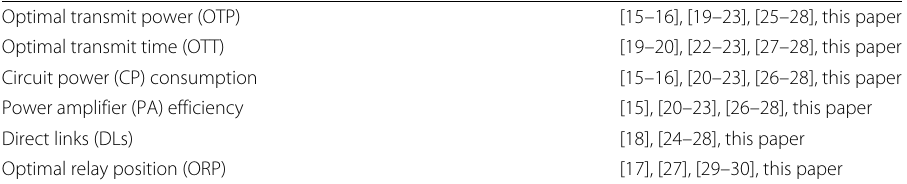
Table 1 Existing literature comparison with this paper Optimal transmit power (OTP) Optimal transmit time (OTT) Circuit power (CP) consumption Power amplifier (PA) efficiency Direct links (DLs) Optimal relay position